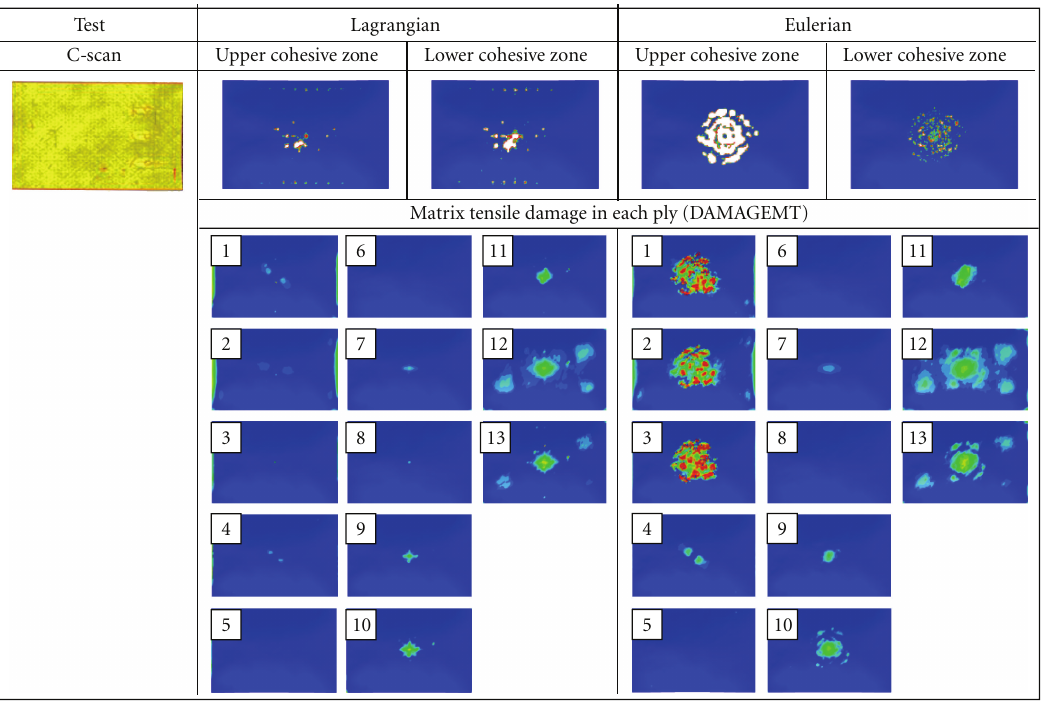
Figure 11: Interlaminar and intralaminar damage after bird impact with 100 m/s.